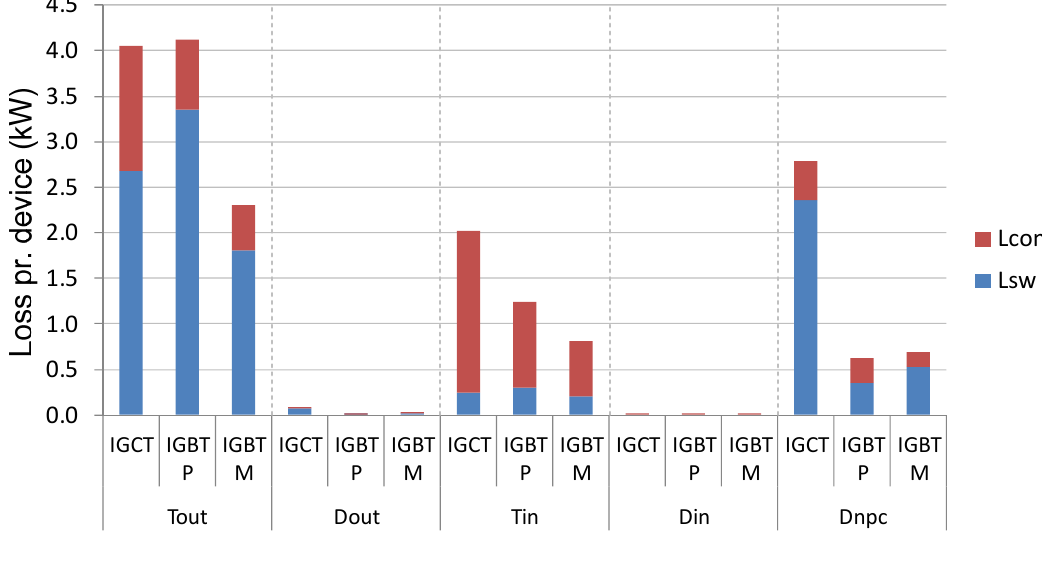
Figure 10. Loss distribution for different power switching devices under normal operation means conduction loss-red, L of Figure 9 ( L con